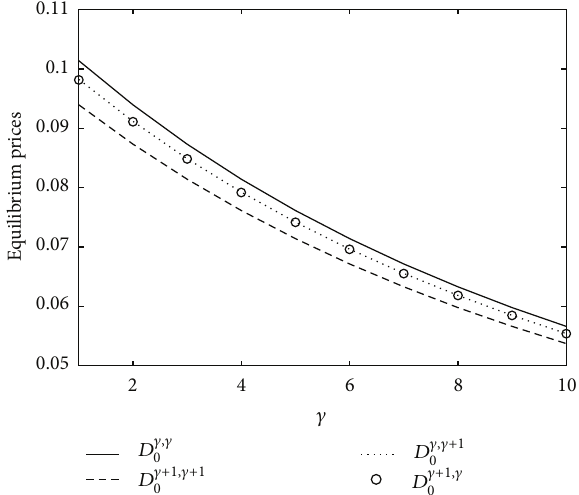
Figure 1: Effect of risk aversion on the equilibrium prices.